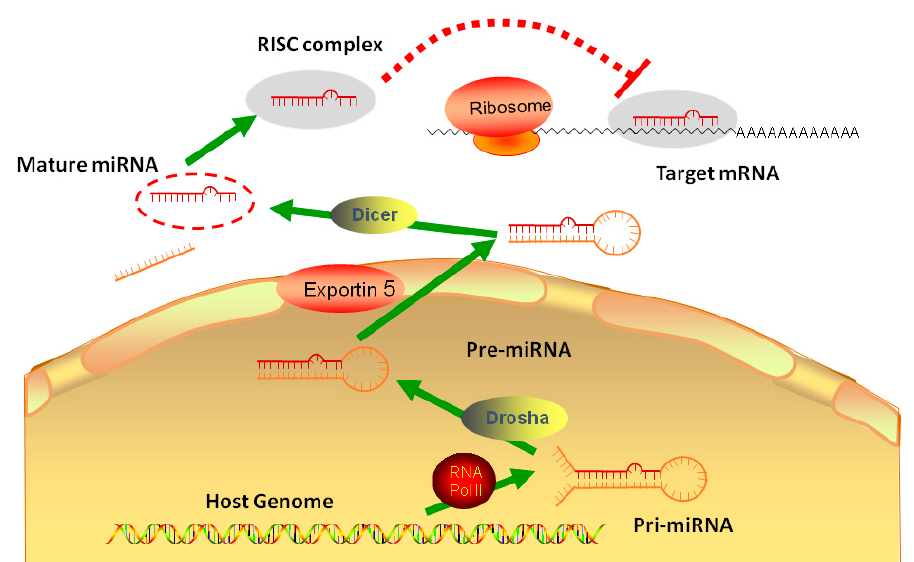
Figure 1. The biogenesis and regulation of microRNA: One miRNA is initially transcribed by RNA polymerase II (RNA Pol II) as part of one arm of a several hundred nucleotide-long primary miRNA (pri-miRNA). The pri-miRNA is cleaved by Drosha, a Class 2 ribonuclease III enzyme, to produce a characteristic stem-loop structure of about 70 base pairs long, known as a pre-miRNA. Endoribonuclease Dicer cleaves pre-microRNA (pre-miRNA) into short single-stranded RNA fragments called mature miRNA in cytoplasm. Mature miRNA form RISC complex to combine the target mRNA.